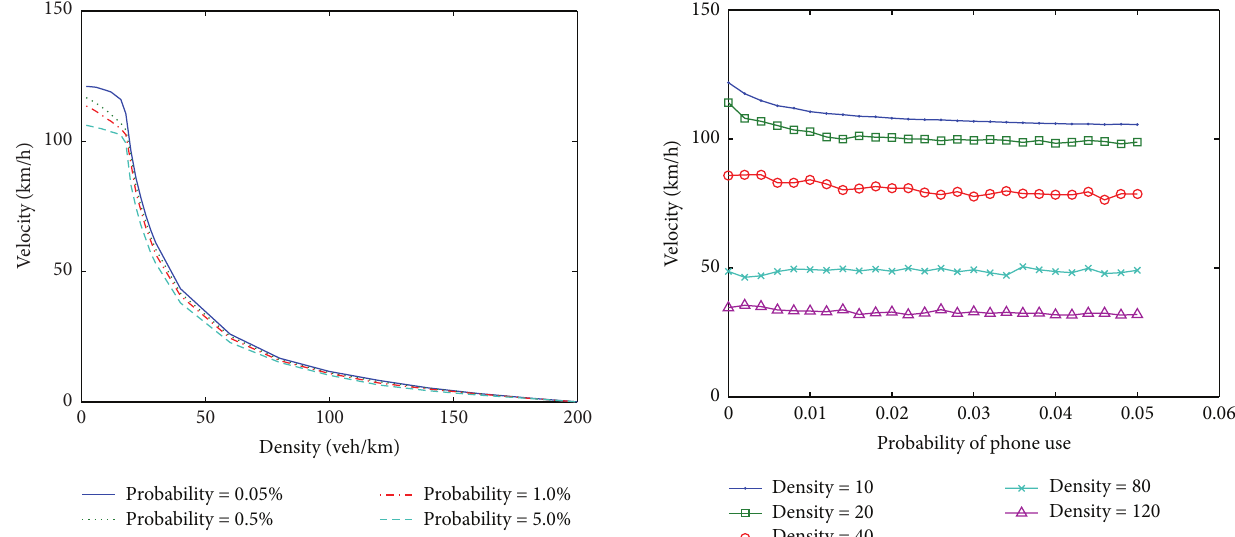
Figure 5: The change of flow rate under different density.